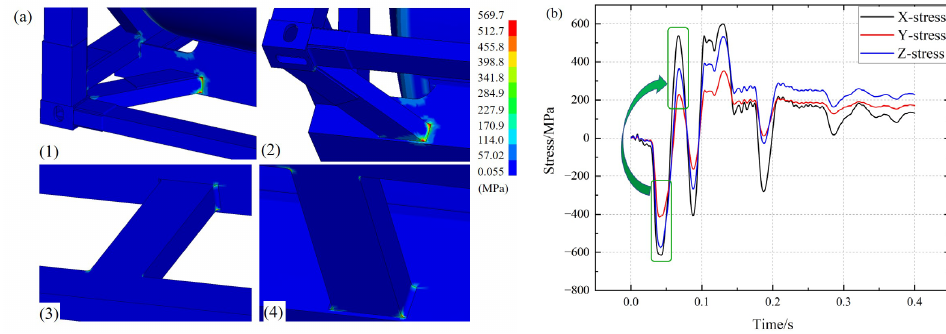
Figure 23. Stress distribution at peak value 2: ( a ) location, ( b ) change of stress state in chamfer.